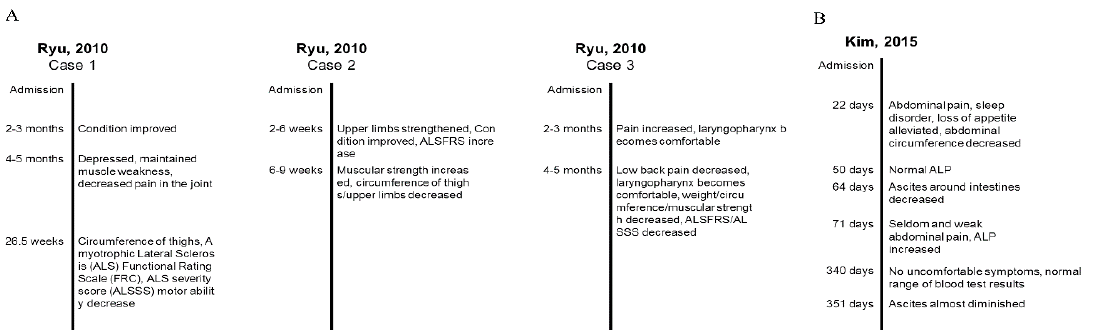
Figure 4. Examples of changes of clinical outcomes induced by ginseng pharmacopuncture over time from two case reports. ( A ) Changes of symptoms of three amyotrophic lateral sclerosis patients after cultivated wild ginseng pharmacopuncture. ( B ) Change of symptoms of a patient with hepatocellular carcinoma after cultivated wild ginseng pharmacopuncture.